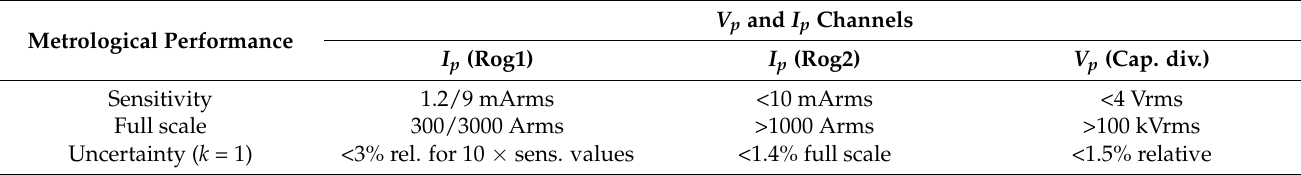
Table 1. Metrological characteristics of V p and I p sensors (Adapted with permission from ref. [47]. 2021 IEEE). Metrological Performance